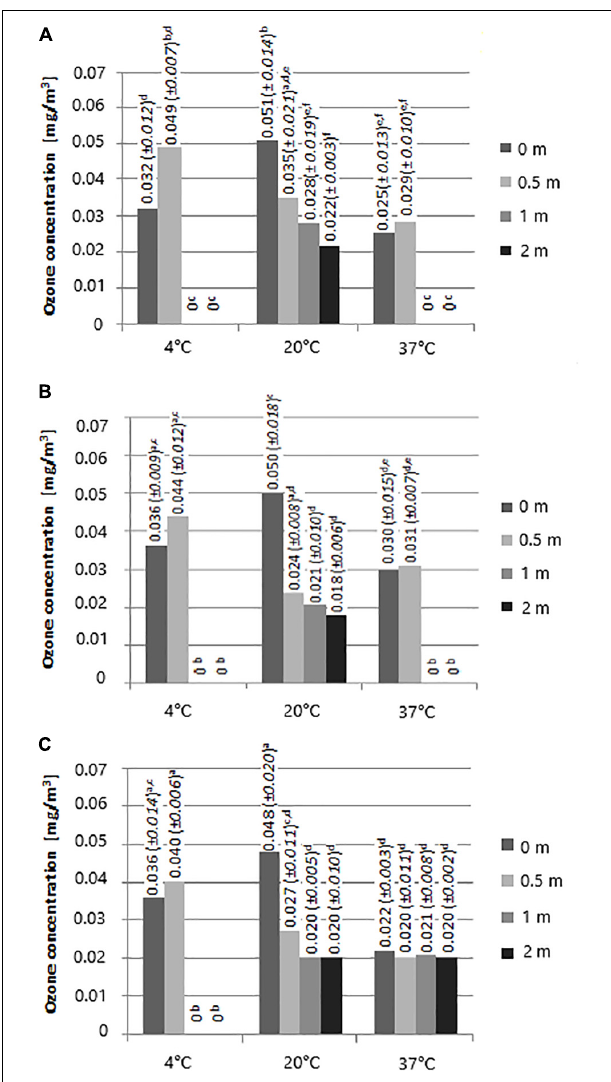
FIGURE 1 | The concentration of ozone in the air during operation of the RCI device for (A) 1 h, (B) 6 h, (C) 12 h depending on the temperature and distance from the source [a, b, c – values marked with different letters are significantly different ( P < 0.05)].